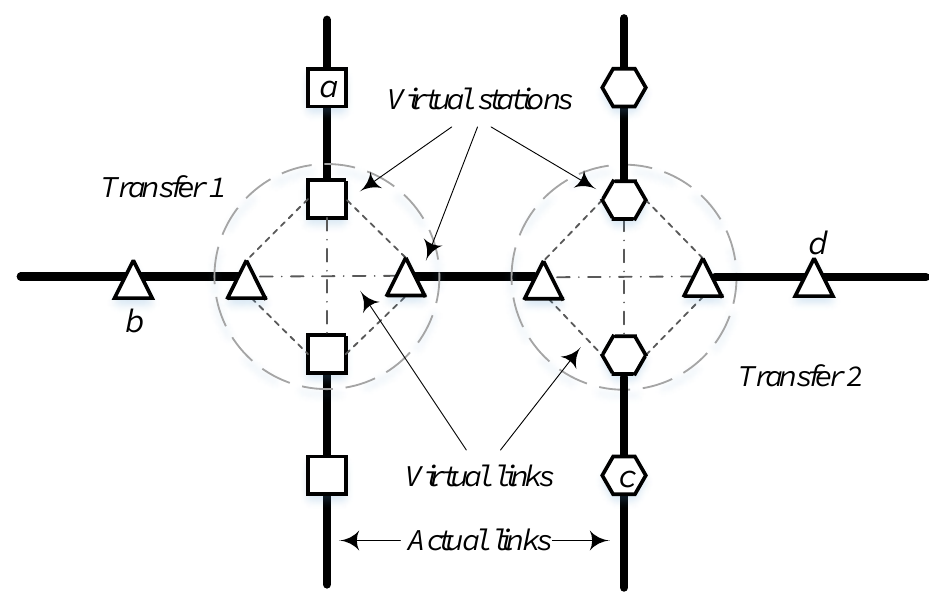
Figure 4. Structure of augmented metro network.